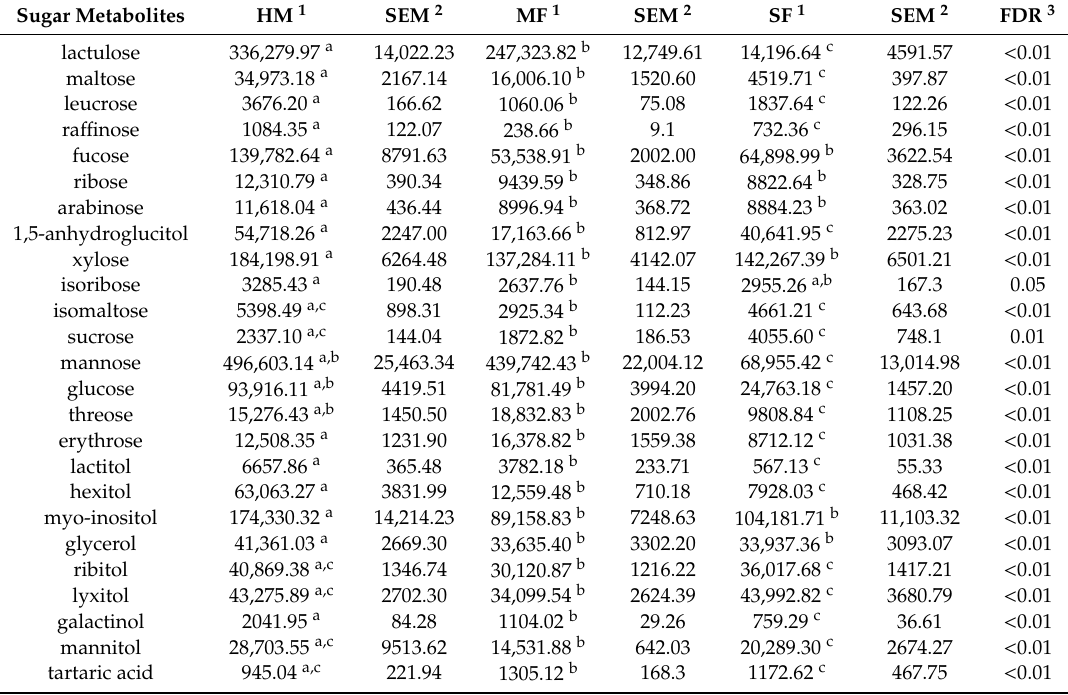
Table 2. Average abundances (quantifier ion (quantion) intensities) of sugar metabolites significantly di ff erent when comparing human milk (HM; n = 93), cow’s milk-based formula (MF; n = 80), and soy-formula (SF; n = 76) diet groups in the urine of infants at 3 months of